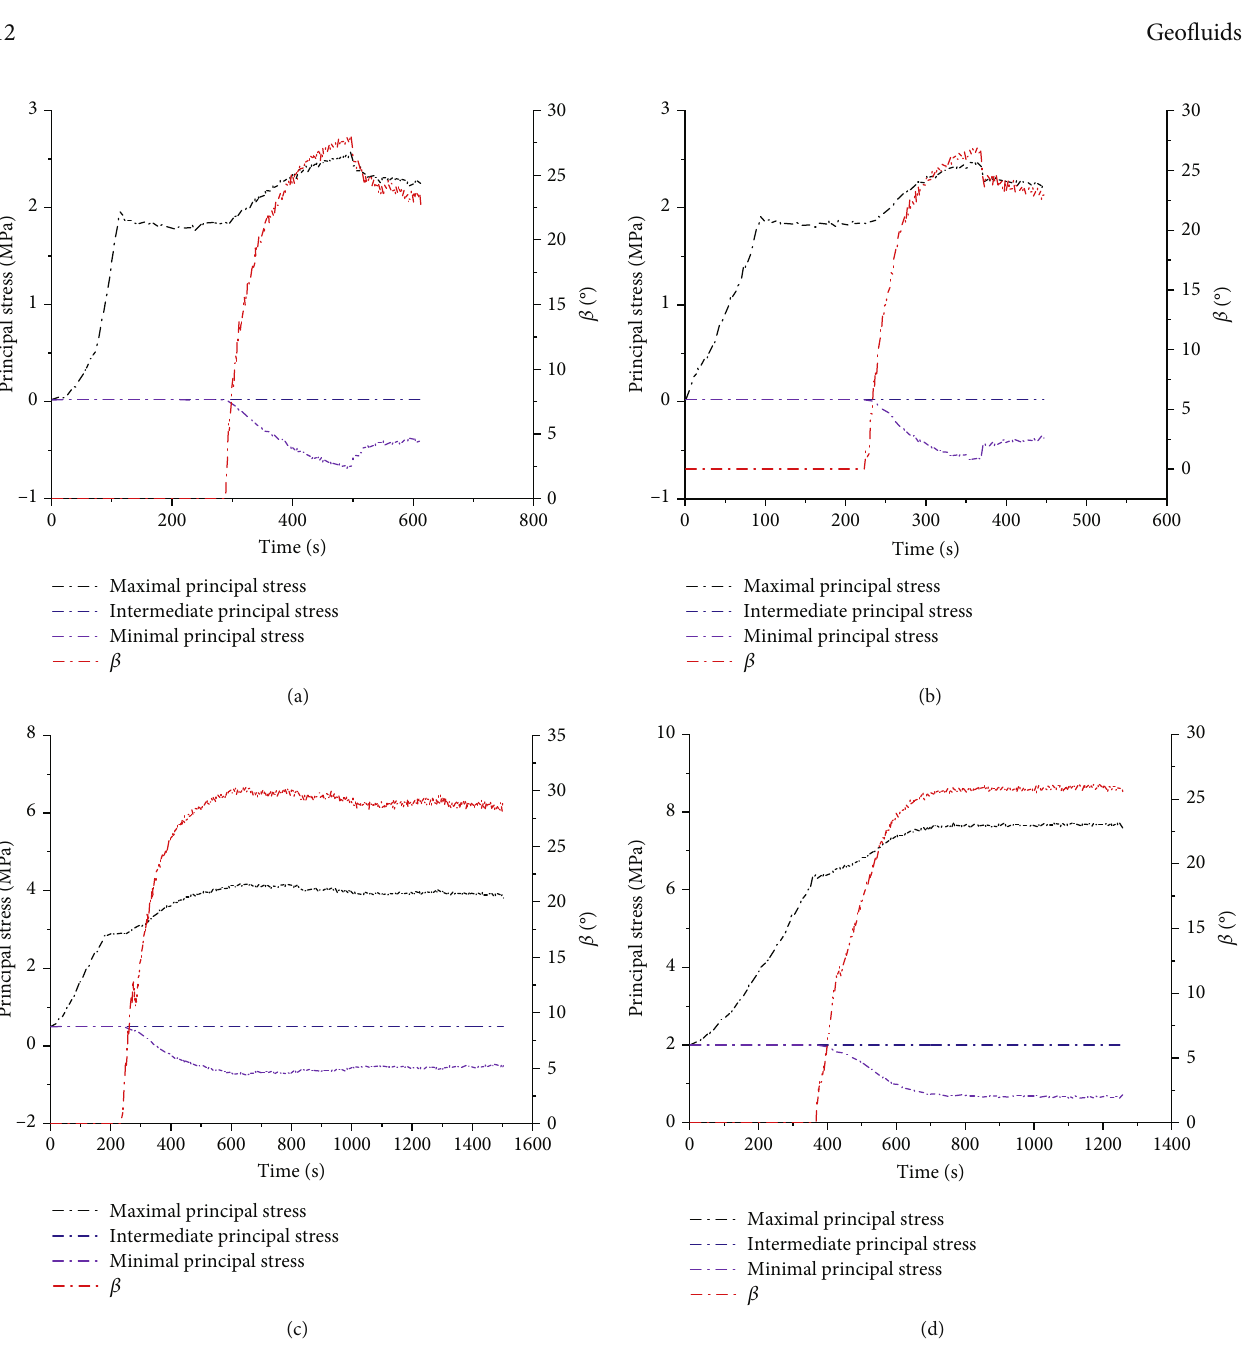
Figure 12: Principal stress and its orientation under cell pressures of (a) 0.0 MPa, (b) 0.02MPa, (c) 0.5MPa, and (d)